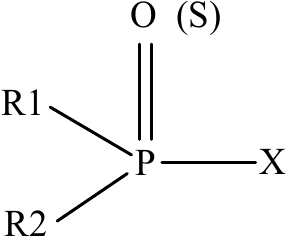
Figure 1. General structure of organophosphorus pesticides [14].